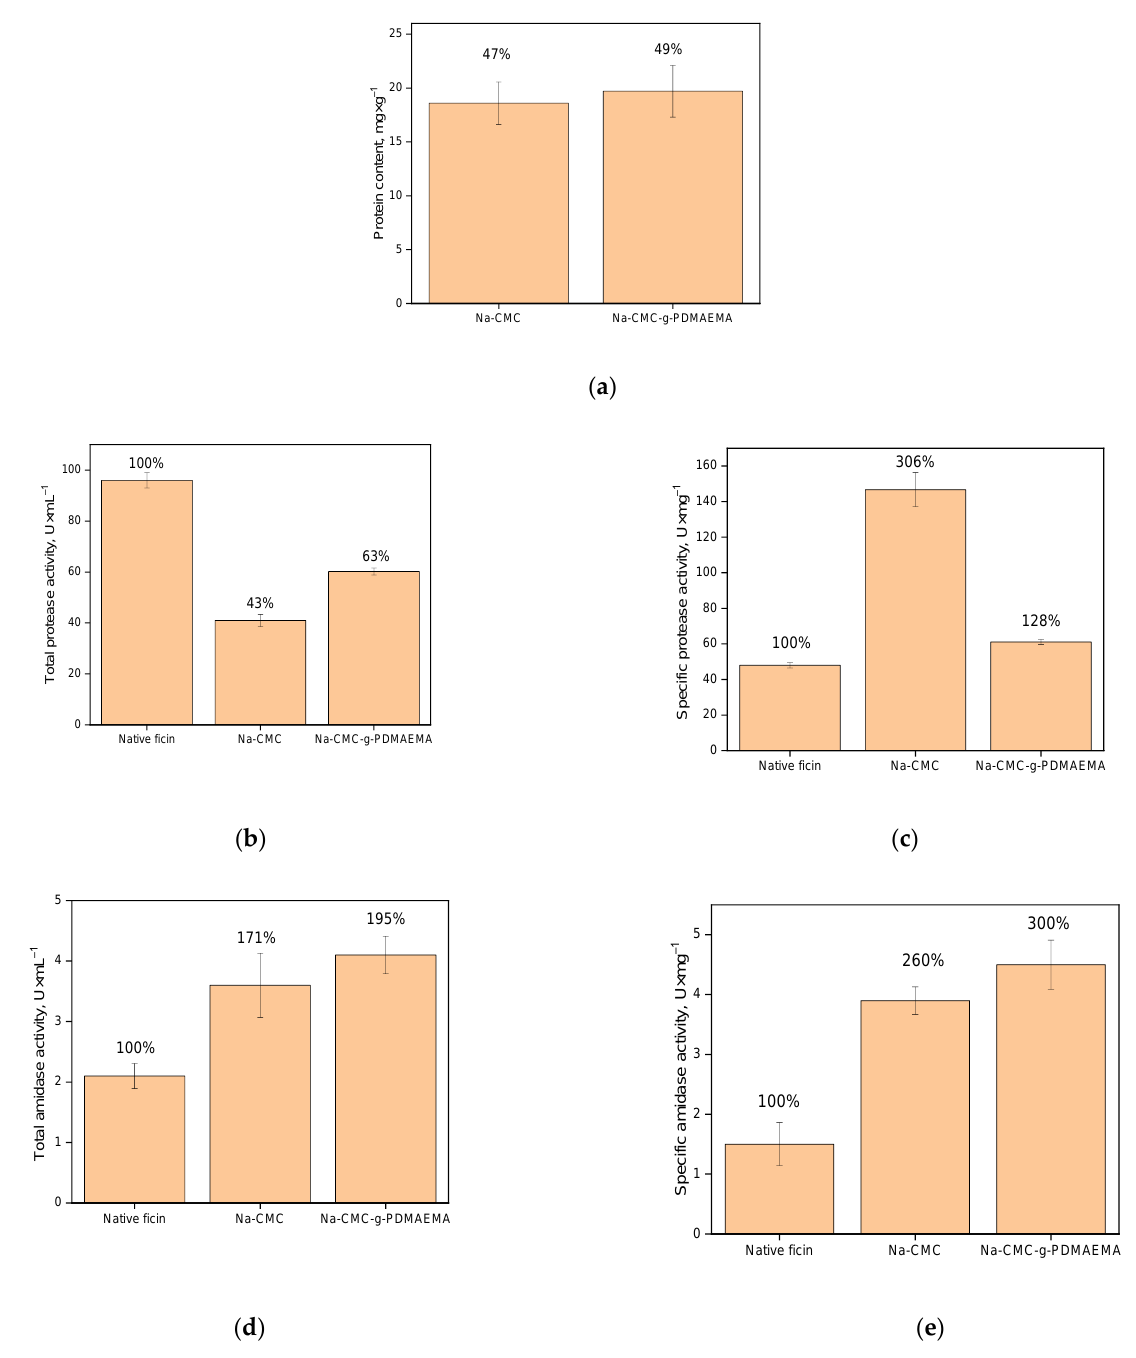
Figure 7. Characteristics of immobilized ficin: ( a ) is protein content (mg · g − 1 of carrier) in the enzyme conjugates with Na-CMC and Na-CMC- g -PDMAEMA; ( b ) is total activity (U · mL − 1 of solution) of the enzyme conjugates with Na-CMC and Na-CMC- g -PDMAEMA; ( c ) is specific activity (U · mg − 1 of protein) of enzyme conjugates with Na-CMC and Na-CMC- g -PDMAEMA; ( d ) is total amidase activity (U · mL − 1 of solution) of the enzyme conjugates with Na-CMC and Na-CMC- g -PDMAEMA; ( e ) is specific amidase activity (U · mg − 1 of protein) of the enzyme conjugates with Na-CMC and Na-CMC- g -PDMAEMA. The immobilization yield for ficin is expressed as a percentage of the adsorbed enzyme to its amount in solution ( a ), of total activity of immobilized enzyme compared to native enzyme ( b , d ), and of specific activity of immobilized enzyme compared to native enzyme ( c , e ) (i.g. immobilization recovery) are indicated above bars. All experiments were performed eight times, and the results represent mean ± confidence